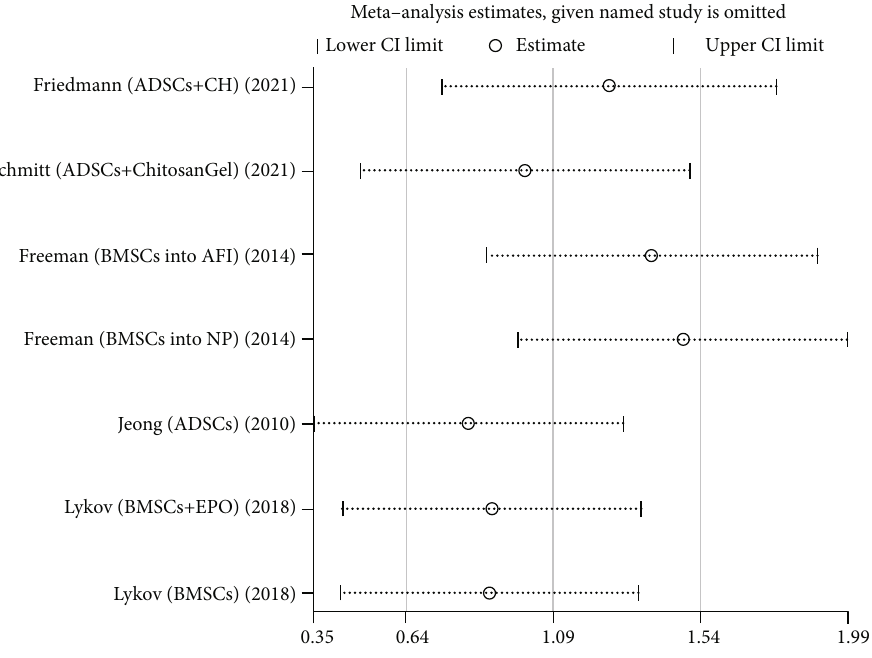
Figure 13: Sensitivity analysis of DHI.